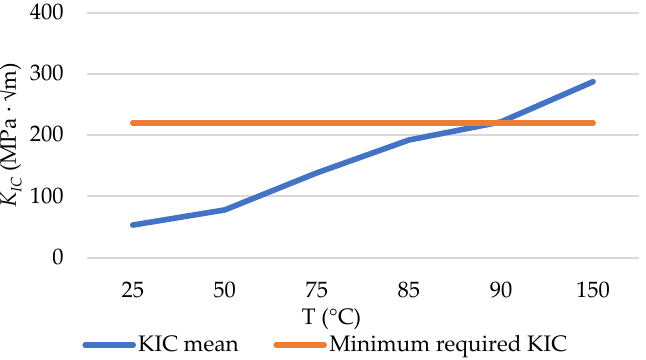
Figure 8. K IC variation versus temperature compared with the minimum required K IC according to ASME FFS.